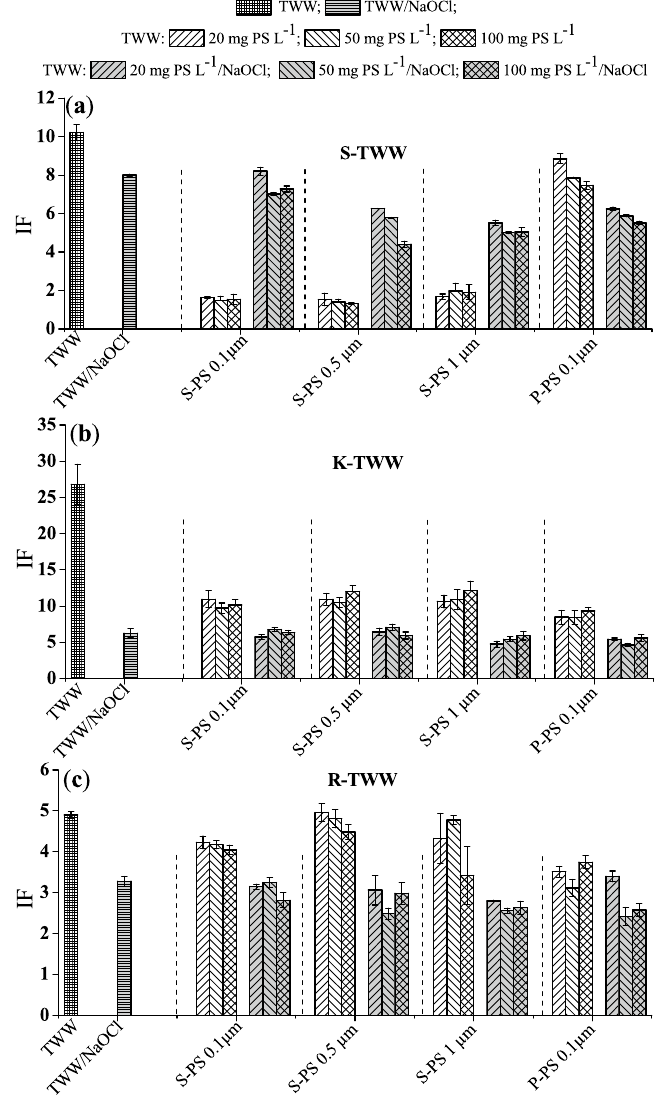
Figure 2. Genotoxicity of TWW effluent samples and the TWW-based suspensions of sulfate polystyrene (S-PS; 0.1, 0.5 and 1 µm) and pristine polystyrene (P-PS; 0.1 µm) particles at concentrations of 20, 50 and 100 mg L −1 before and after chlorination (20 mg L −1 of chlorine; by NaOCl). ( a ) Shafdan TWW effluent (S-TWW), ( b ) Karmi ′ el TWW effluent (K-TWW), ( c ) Raanana TWW effluent (R-TWW). The error bars represent one standard